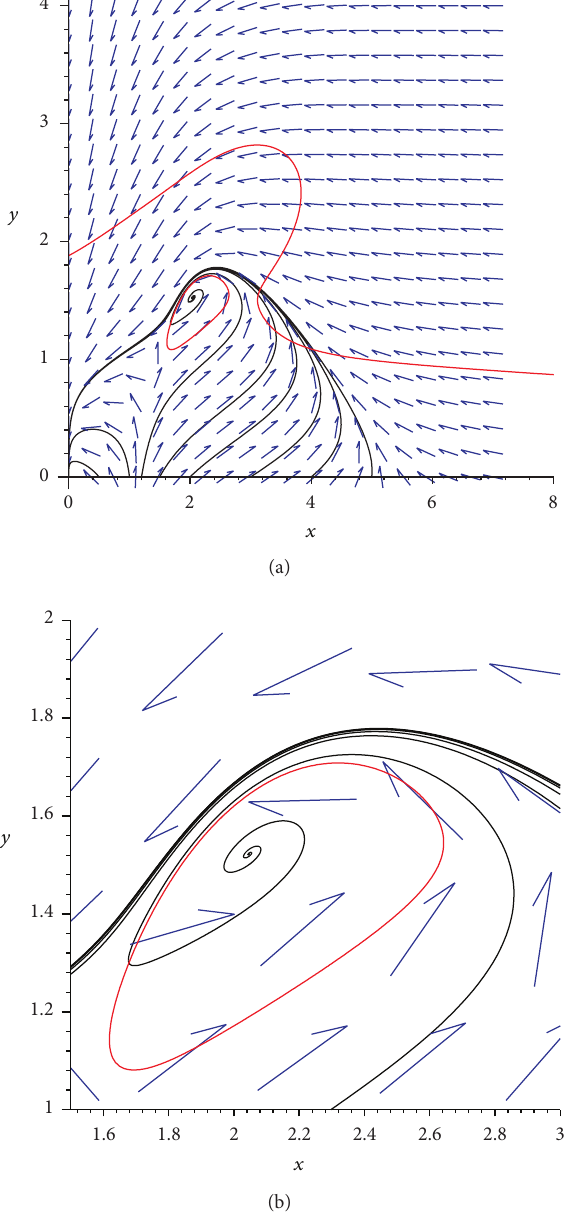
Figure 3: (a) the DOA when (𝐴, 𝛽,𝑣, 𝑐, 𝑎,𝜇, 𝑘) = (6,0.5, 1.27, 2, 4, 1, 0.5) for the model (20), (b) a detailed look for the phase portrait in